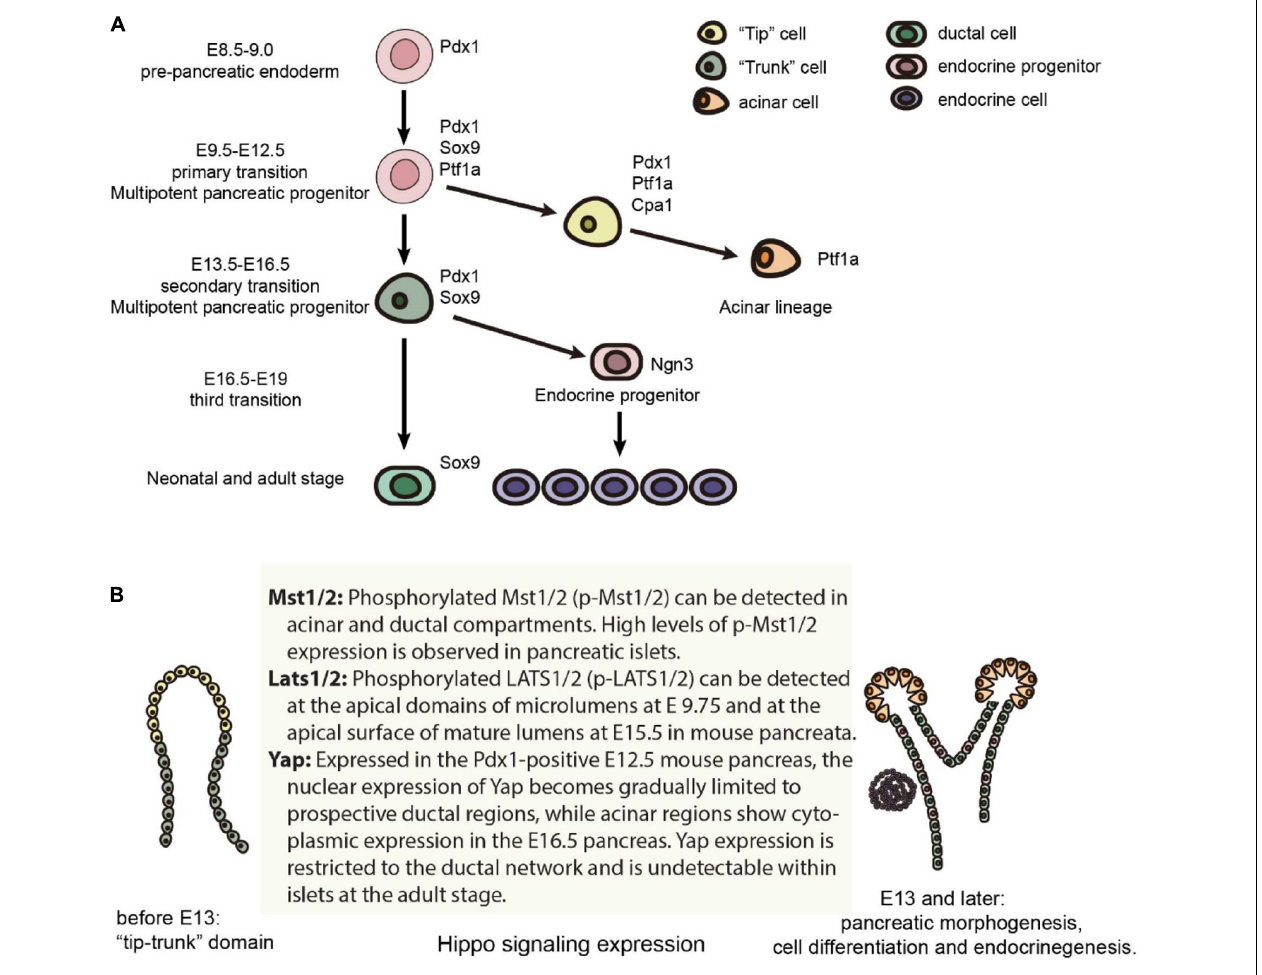
FIGURE 1 | Mouse pancreas development and the expression of Hippo components. (A) Major cell lineages in the pancreas and the master regulators of each lineage. (B) The expression of Hippo components in the mouse